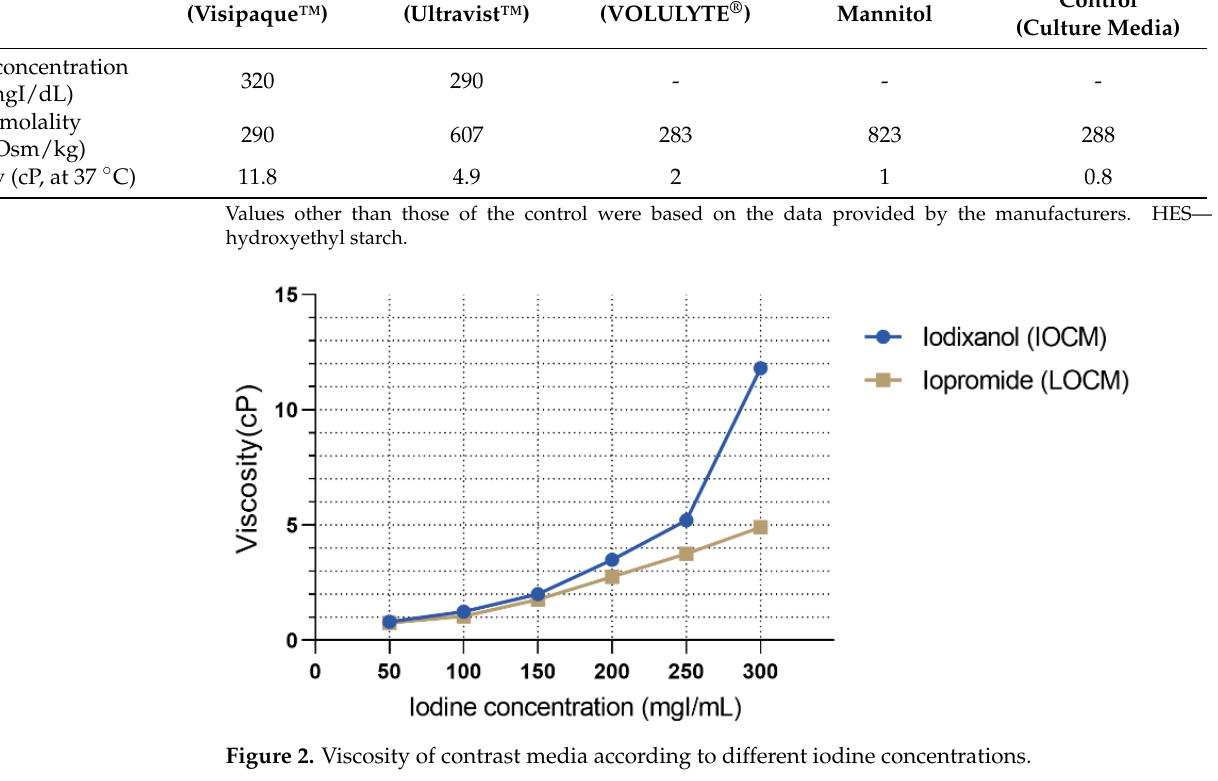
Figure 2. Viscosity of contrast media according to different iodine